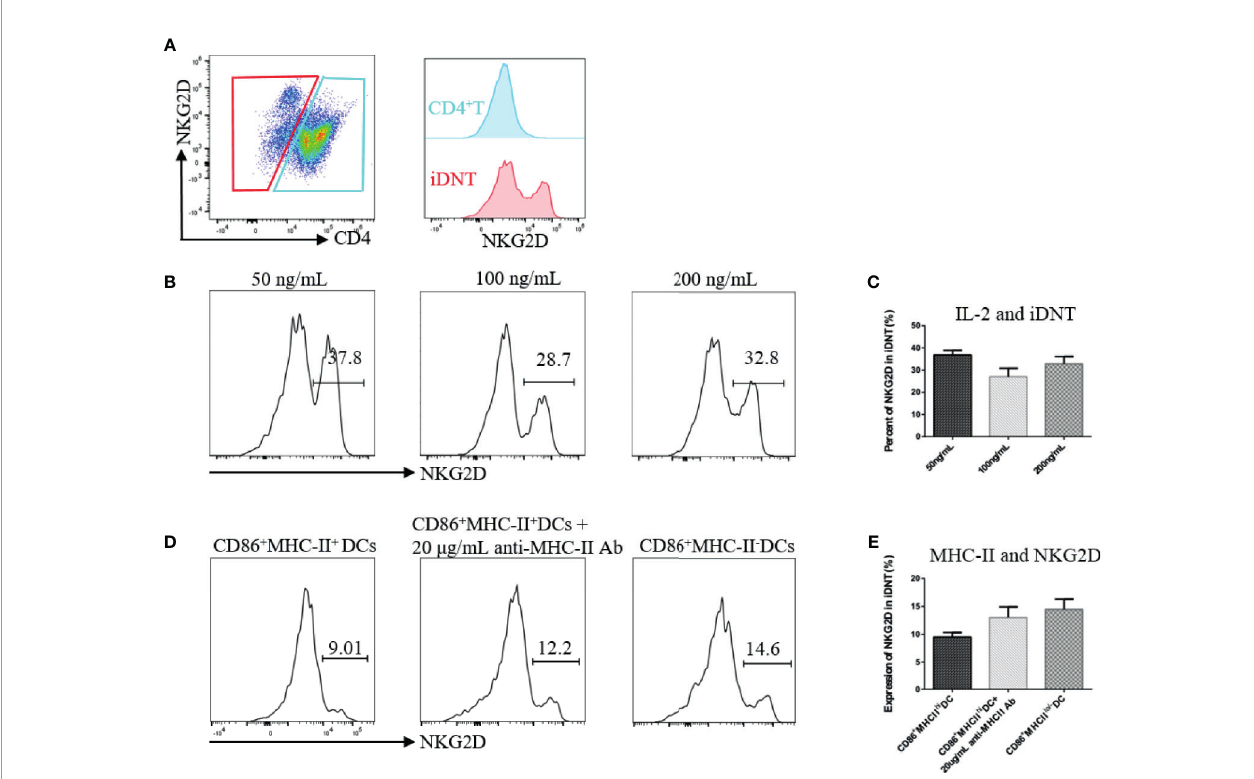
FIGURE 2 | IL-2 and MHC-II may regulate NKG2D expression on iDNT cells. (A) A representative experiment shows that a group of iDNT cells expressed NKG2D molecules. (B, C) Nonregulatory CD4 + T cells were cocultured with mature bone marrow dendritic cells (CD86 - MHC-II + DCs). IL-2 (50 ng/mL, 100 ng/mL or 200 ng/mL) was added to the mixed lymphocyte reaction. After successful induction, the percentage of NKG2D on iDNT cells was detected using fl ow cytometry. (B) Histograms are representative of NKG2D expression on iDNT cells. (C) The bar graphs are representative of three independent experiments. (D, E) Immature DCs (CD86 + MHC-II - ), mature DCs (CD86 + MHC-II + ) or mature DCs with anti-MHC-II antibody (20 m g/mL) were cocultured with nonregulatory CD4 + T cells. IL-2 (20 ng/mL) was added to the mixed lymphocyte reaction. After successful induction, the percentage of NKG2D on iDNT cells was analyzed using fl ow cytometry. (D) Histograms are representative of NKG2D expression on iDNT cells. (E) The bar graphs are representative of three independent